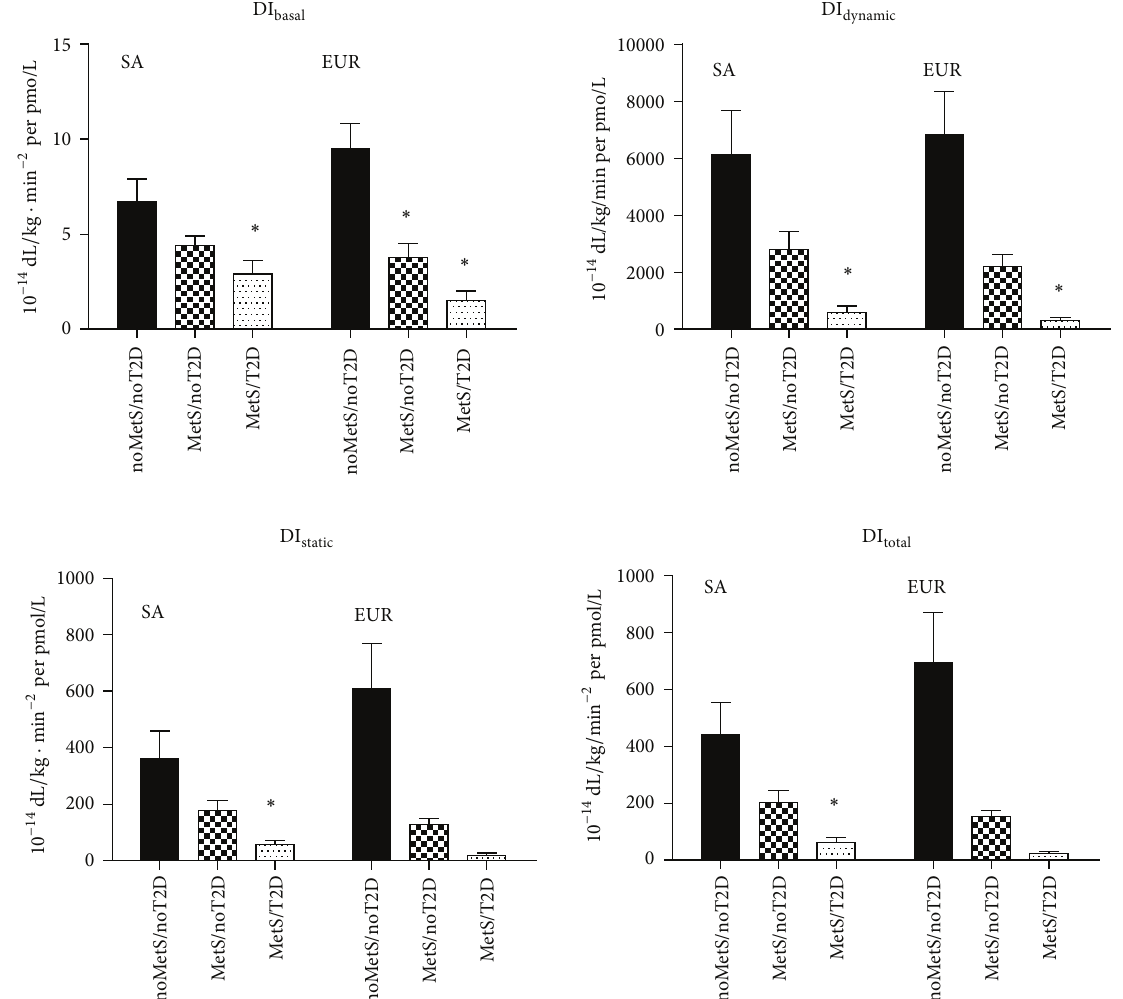
Figure 3: Disposition indices in South Asian (SA) and European (EUR) subgroups. ∗ indicates a statistically significant difference in comparison with the noMetS/noT2D